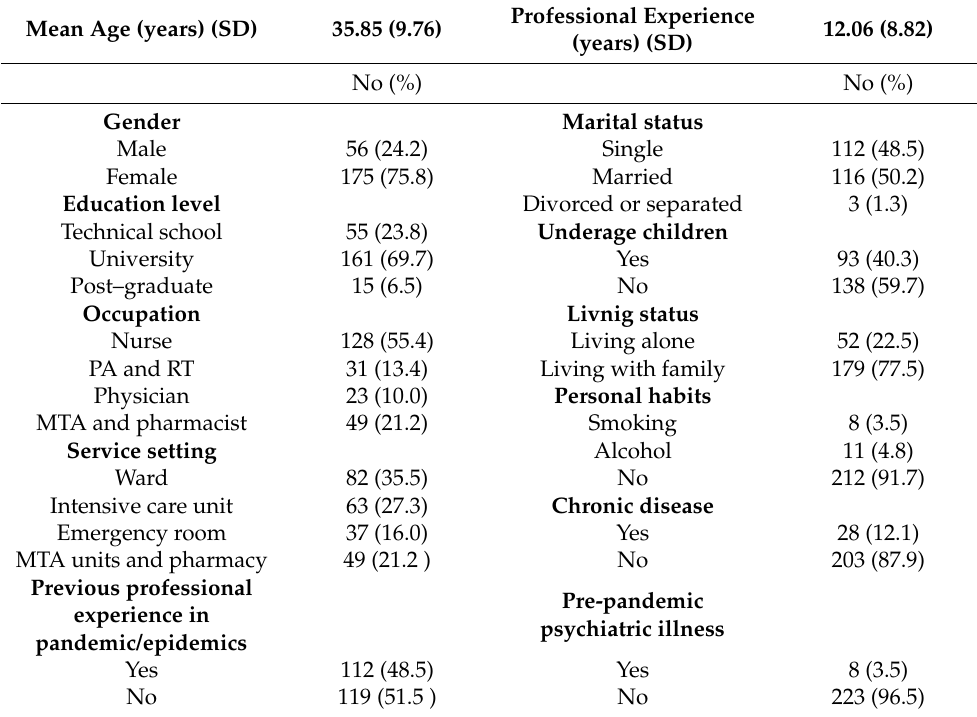
Table 2. Sociodemographic characteristics of the respondents.